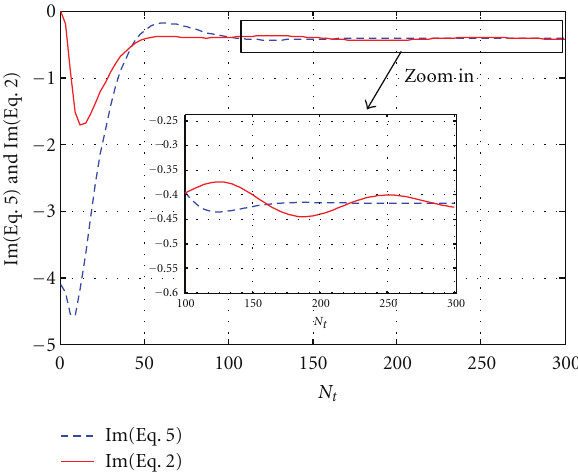
Figure 2: Comparison of (cid:2) G E and (5).